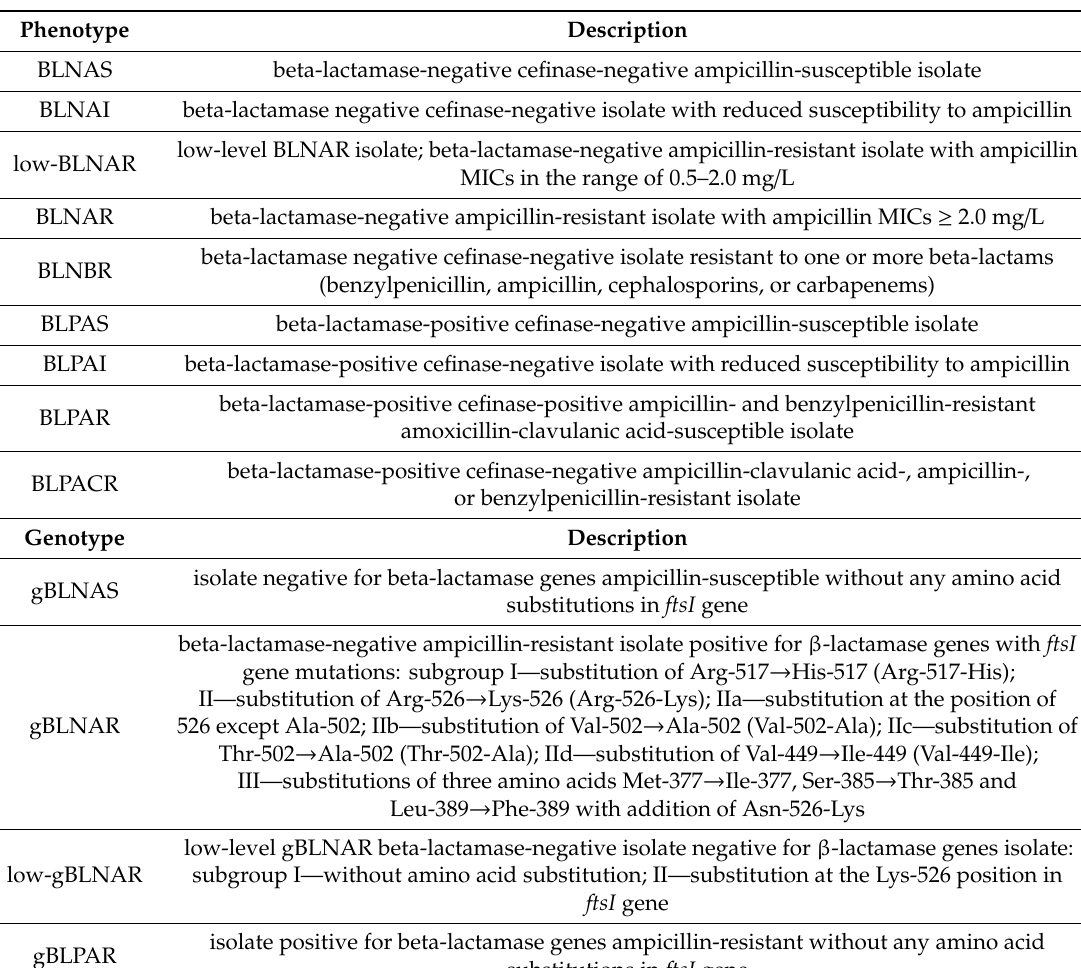
Table 2. Classification of phenotypes of Haemophilus parainfluenzae isolates based on the results of drug susceptibility to